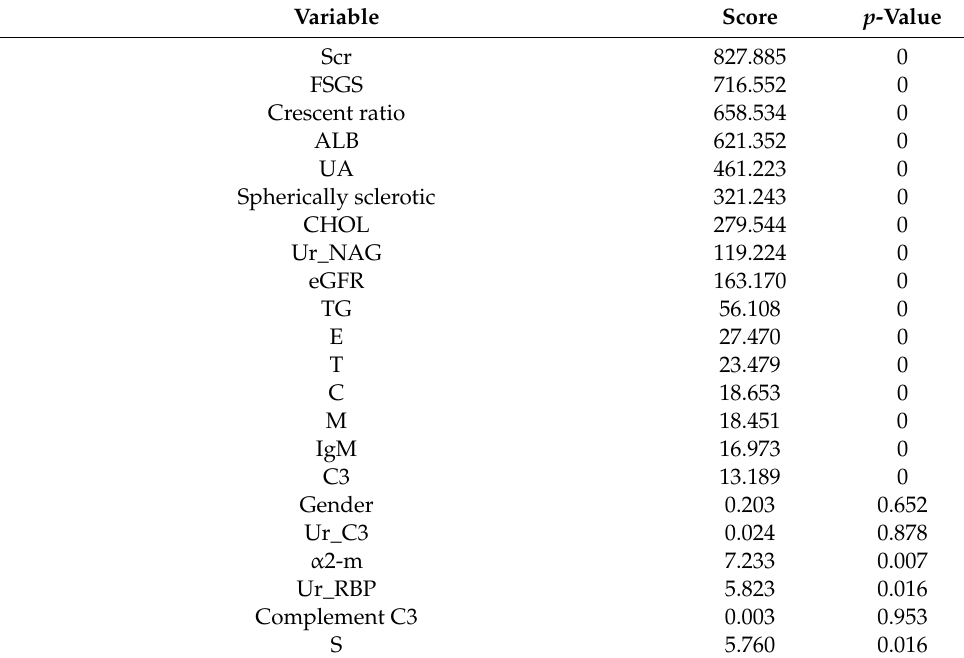
Table 4. Chi-square analysis results of